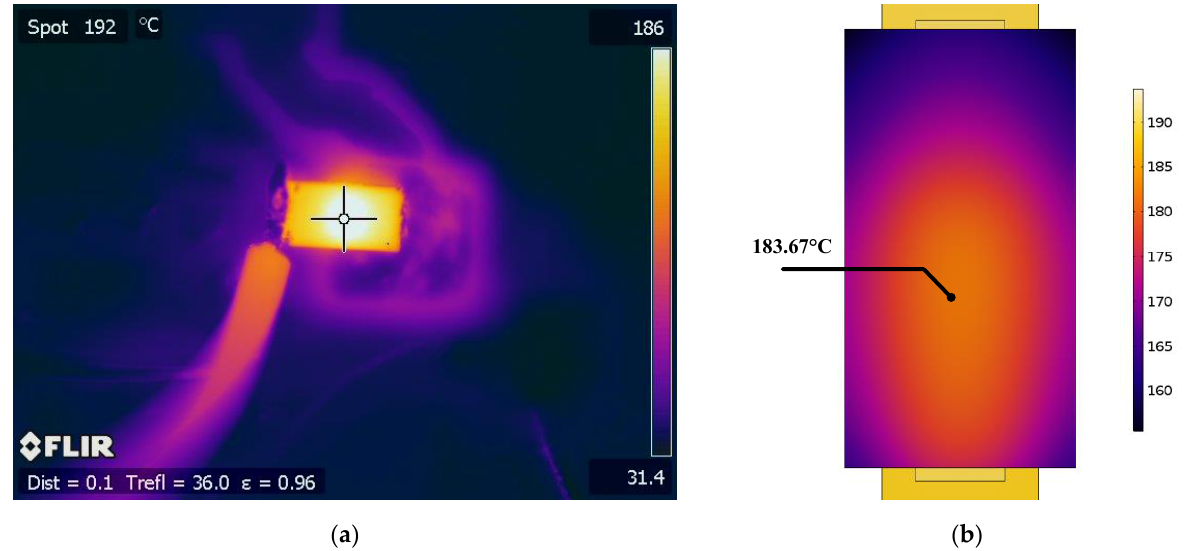
Figure 15. The Comparison for 500 (mA) forward current: ( a ) measurement; ( b ) simulation result.